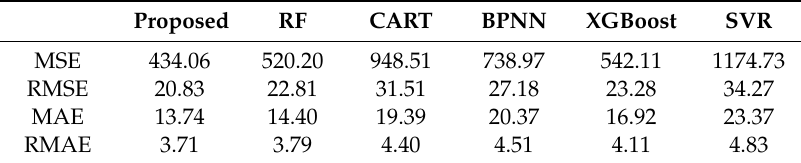
Table 2. Evaluated results of different wind power forecasting models.